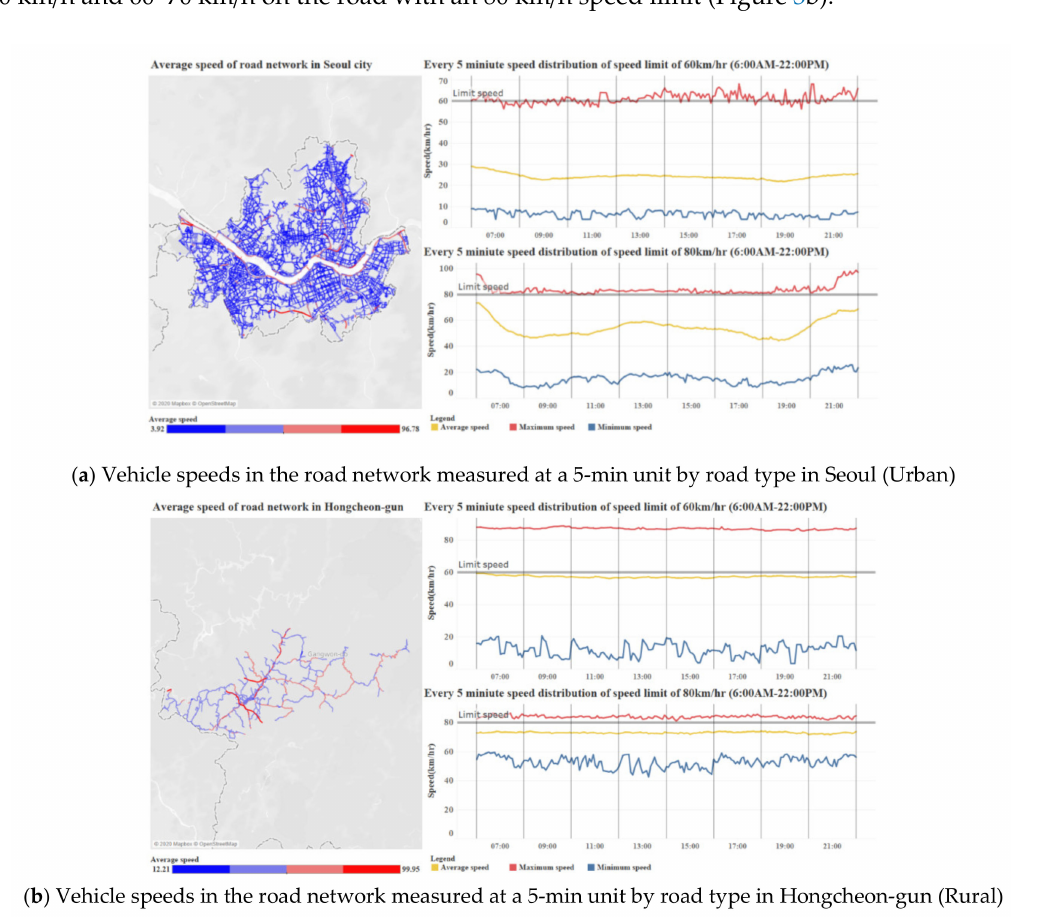
Figure 3. Vehicle speeds in the road network measured at a 5-min unit by road type in urban and rural areas. The average speed of roads is shown in blue to red on each road map. The distribution of the actual vehicle speed is indicated by road type (speed limit of 60 km / h and 80 km / h) on the right side in the line